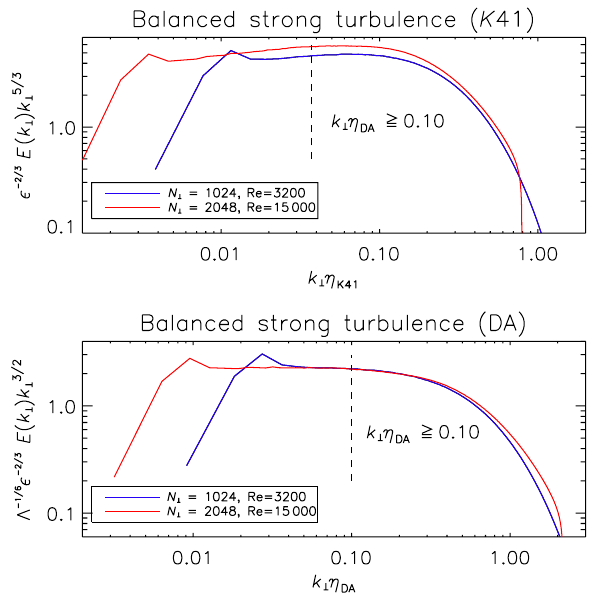
FIG. 10. Comparison of the spectra obtained in numerical runs RB2c and RB3a, rescaled by the Kolmogorov dissipation scale (cid:10) K 41 ¼ (cid:1) 3 = 4 (cid:9) (cid:1) 1 = 4 (upper panel) and by the dissipation scale obtained in the dynamic alignment theory (cid:10) DA ¼ (cid:1) 2 = 3 (cid:1) 1 = 9 (cid:9) (cid:1) 2 = 9 ; see (8) (lower panel). In these runs, the numerical discretization is not related to the dissipation scale as N ? (cid:10) ¼ const . With no spurious numerical convergence imposed by the numerical setup, the (cid:1) 5 = 3 model does not fit the data, while the dynamic alignment model shows a good agreement in the inertial interval and in the dissipation range, up to the scales where the numerical effects eventually become